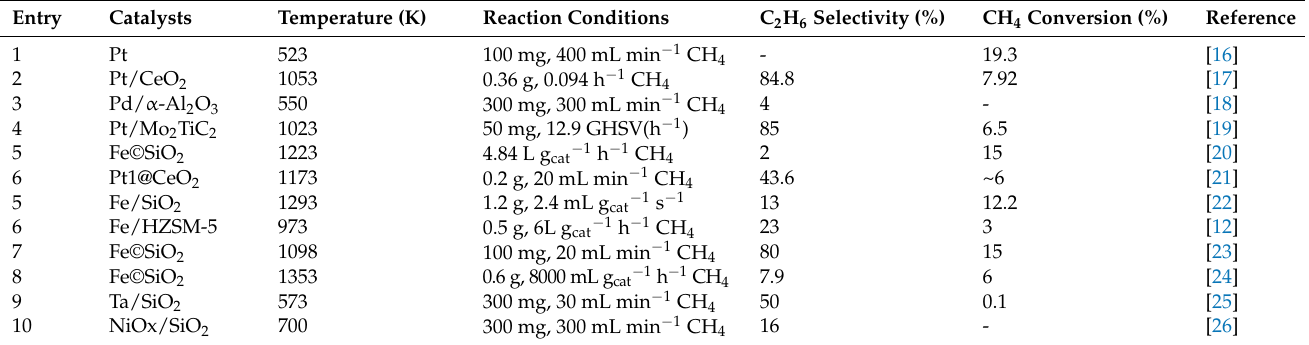
Table 1. C 2 H 6 selectivity and CH 4 conversion in thermal catalytic NOCM using different